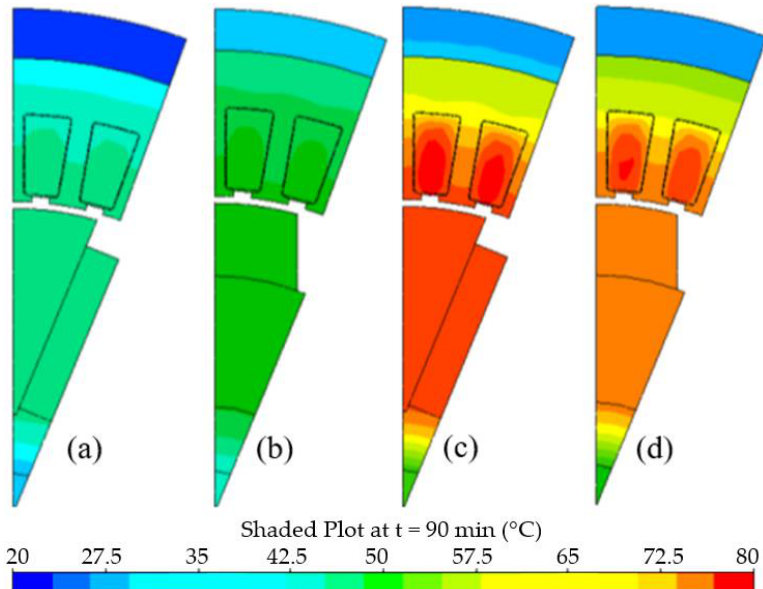
Figure 8. Thermal models of the tangential and radial machines with various current density (J) in the winding: ( a ) tangential machine with J = 8.5 A/mm 2 , ( b ) radial machine with J = 8.5 A/mm 2 , ( c ) tangential machine with J = 6.2 A/mm 2 , ( d ) radial machine with J = 16.2 A/mm 2 .